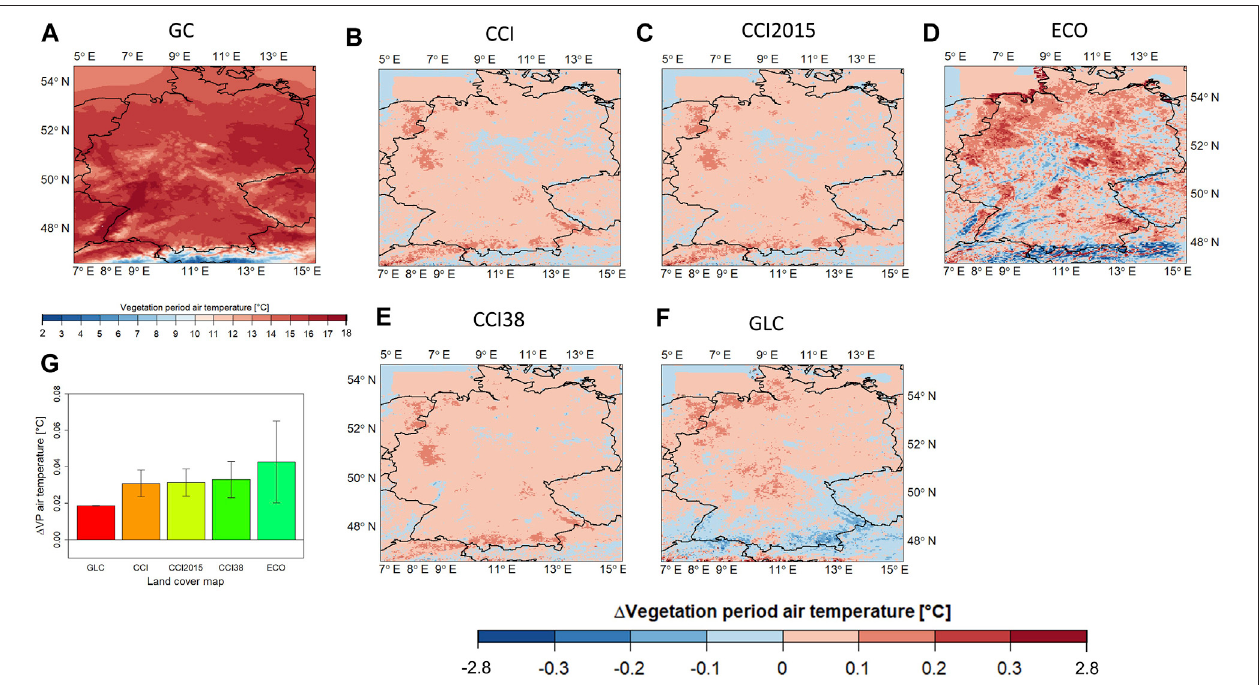
FIGURE6| Distributionofdailyvegetationperiod2-mtemperatureclimatology(2002 – 2011)forthecontrolsimulationbasedonGlobCover2009 (A) ,thedifference between the simulation based on CCI and the control simulation (B) , the difference between the simulation based on CCI2015 and the control simulation (C) , the difference between the simulation based on ECO and the control simulation (D) , the difference between the simulation based on CCI38 and the control simulation (E) , and the difference between the simulation based on GLC2000 and the control simulation (F) . Domain averaged differences in vegetation period 2-m temperature forGLC,CCI,CCI2015,CCI38,andECOcomparedwiththecontrolsimulationbetween2002and2011 (G) .Pleasesee Table1 forabbreviations.Gridswithanoverlaid black circle indicate statistically signi fi cant (at the 95th percentile level using the t -test) differences.